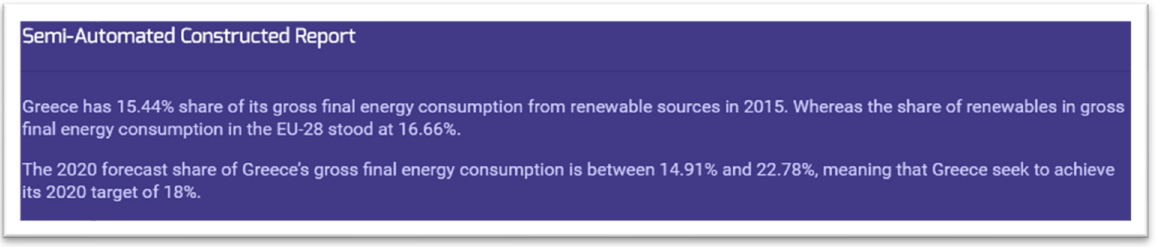
Figure 6. Semi-automated constructed report for an EU country.